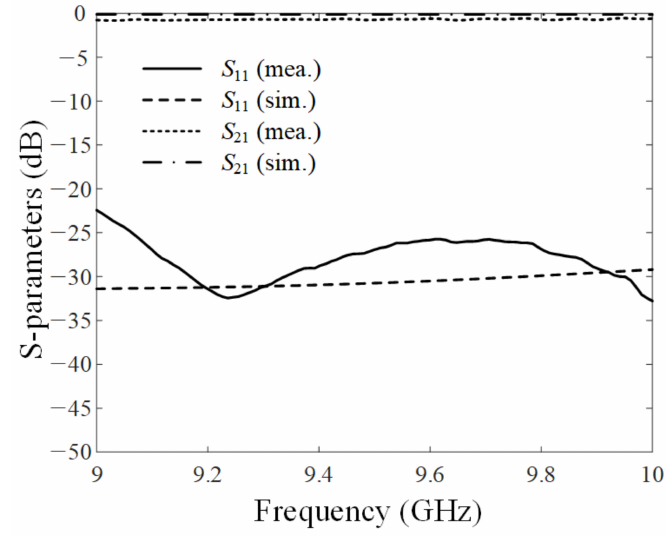
Figure 3. Reflection and transmission coefficients of the proposed interface layer in the back-to-back configuration.